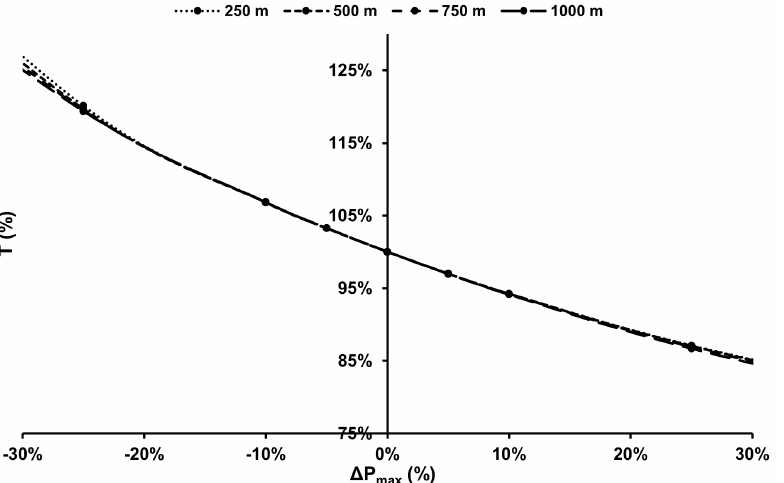
Figure 14. Change in the calculated run-time of the generic athlete as a function of change in the fatigue-free maximum power output P max for distances from 250 to